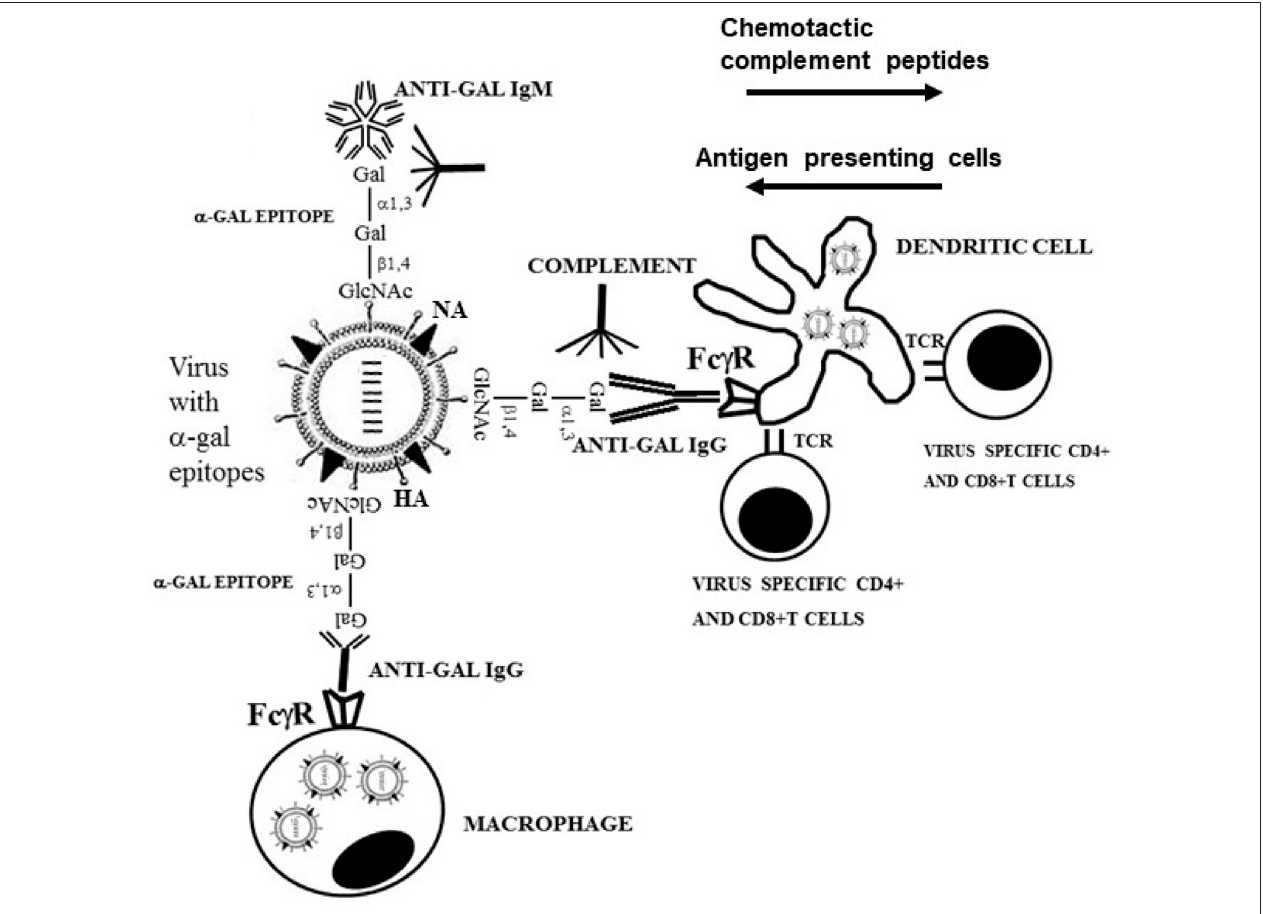
FIGURE5| Ampli fi cationofviralvaccineimmunogenicitybyimmunocomplexingofinactivatedvirionspresenting α -galepitopeswiththenaturalanti-Galantibodyat the vaccination site. Inactivated in fl uenza virus presenting α -gal epitopes is illustrated as vaccine example. Anti-Gal IgM and IgG molecules bind to α -gal epitopes on the vaccinating virus and activate the complement system. The formed complement cleavage chemotactic peptides C5a and C3a direct the extensive chemotactic migration of APCs such as dendritic cells and macrophages to the vaccination site. Anti-Gal IgG immunocomplexed to the virus targets it for extensive uptake by recruited dendritic cells and macrophages via Fc/Fc γ receptor (Fc γ R) interaction. These cells transport the internalized virus vaccine to regional lymph nodes, process and present viral antigenic peptides on class I and class II MHC molecules for activation of virus-speci fi c CD8 + and CD4 + T cells, respectively. HA, hemagglutinin; NA, neuraminidase; TCR, Tcell receptor. Modi fi ed from Galili U. The natural anti-Gal antibody as foe turned friend in medicine. PublishersAcademic Press/Elsevier, London, 2018, with permission.